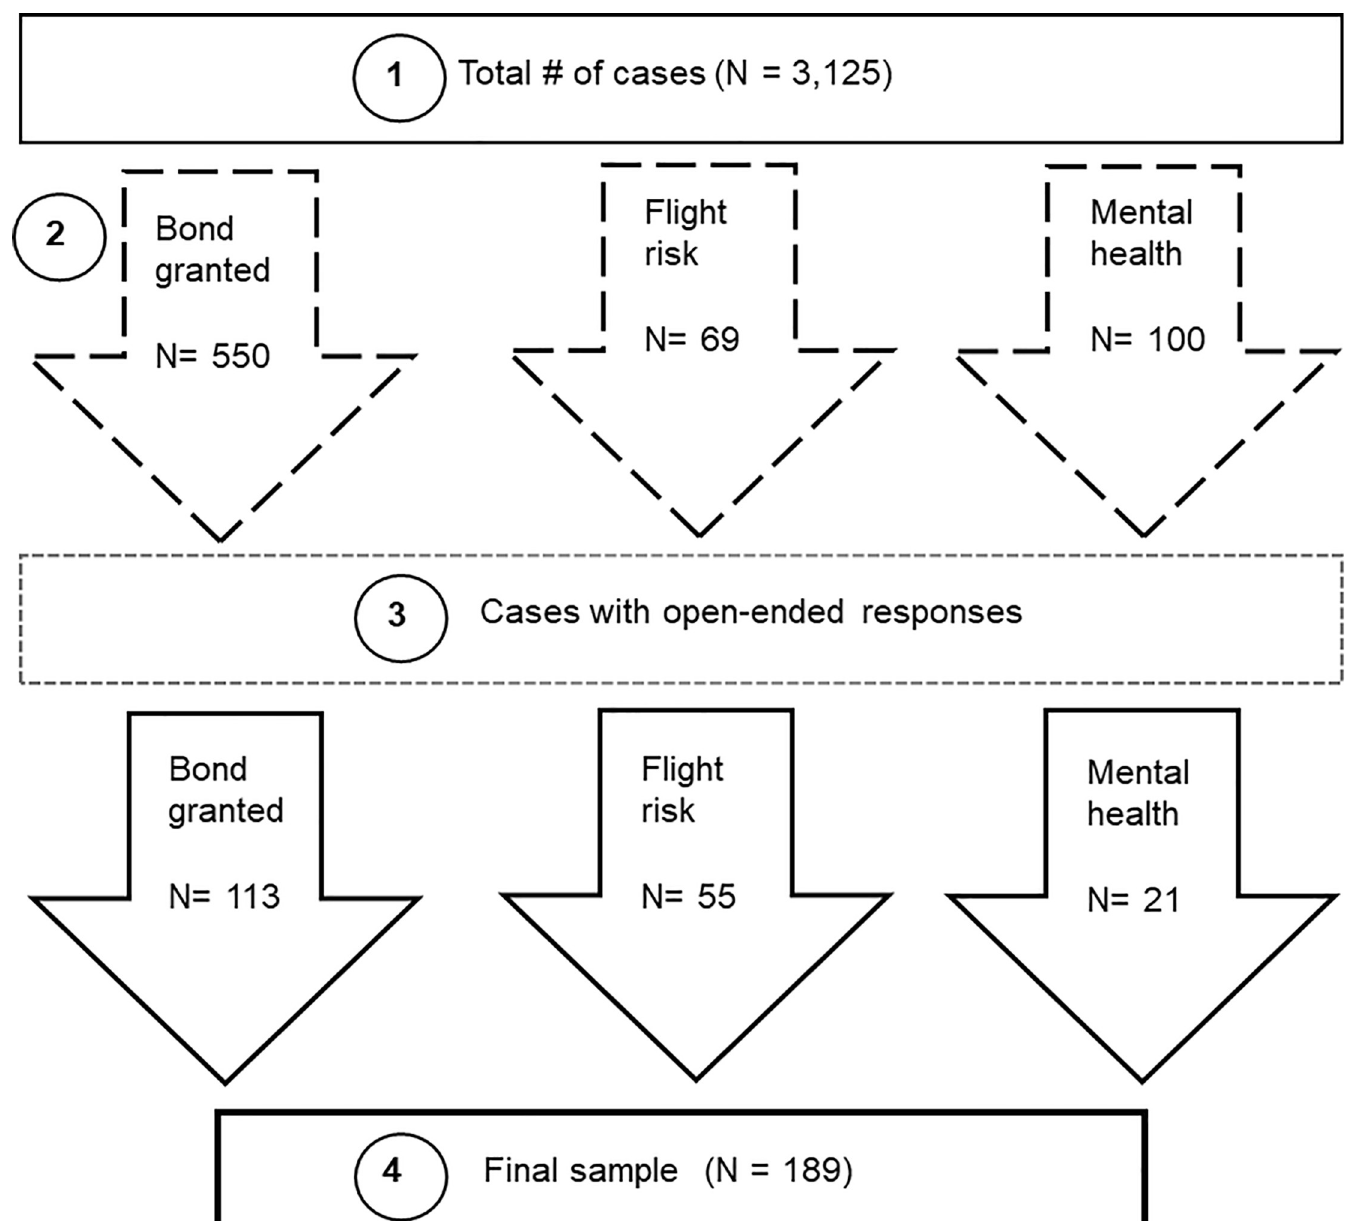
Fig 1. Framework for open ended data extraction